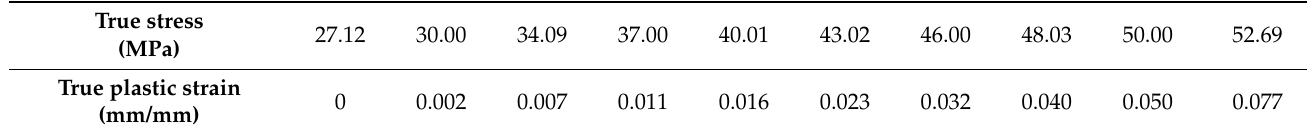
Table 3. PA12 material non-linear properties